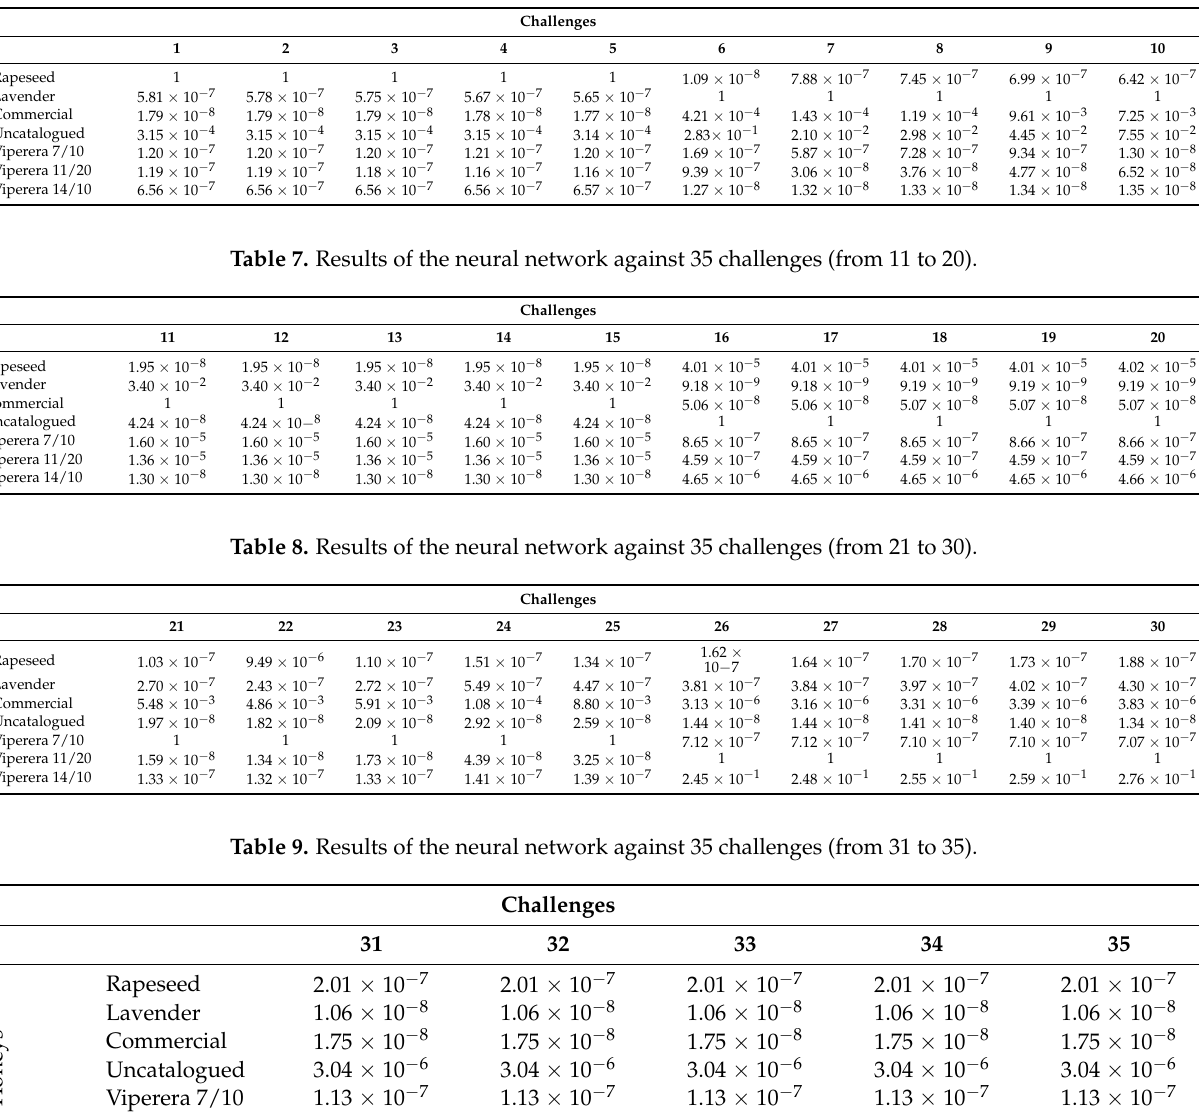
Table 6. Results of the neural network against 35 challenges (from 1 to 10).